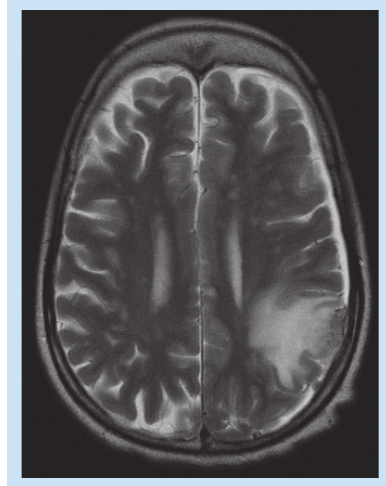
Fig. 2 a. Axial T2WI of a patient with a focal meningoencephalitis and associated vasogenic oedema L posterior parietal as T2 high